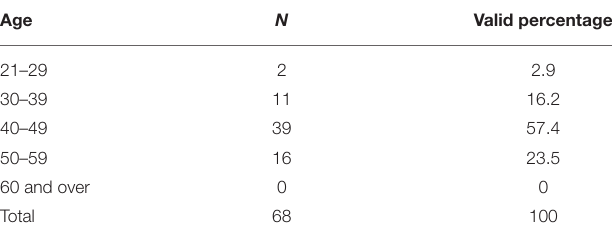
TABLE 1 | Age ranges of participating